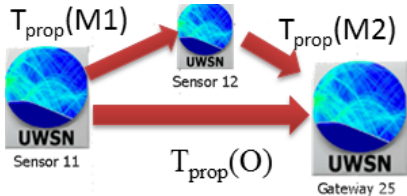
Figure 13. Signal propagation times: OH vs . MH.